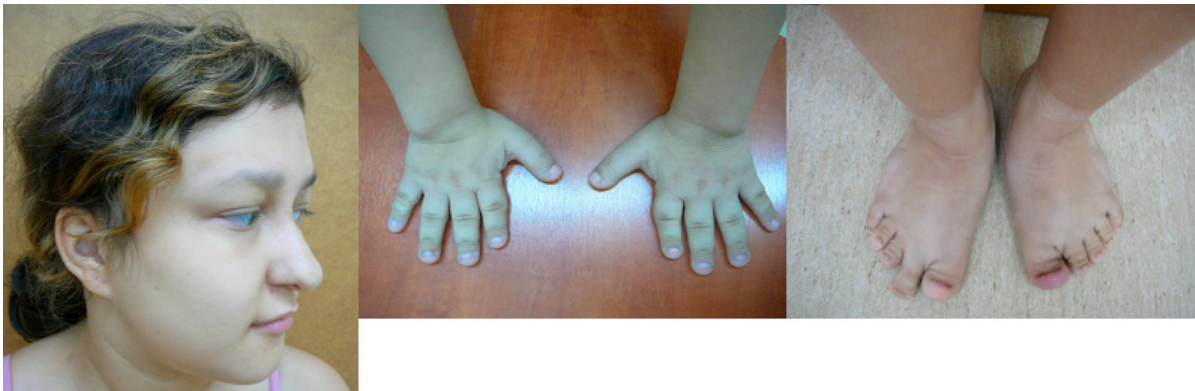
Figure 4. Facial features of patients suspected to have KBG syndrome without ANKRD11 mutations: Patient 24 ‐ a,b— Weiss ‐ Kruszka syndrome; Patient 25 ‐ a,b—Keipert syndrome; and Patient 26 ‐ a,b—Pierpont syndrome. In all patients, note the elongated palpebral fissures and short nose, which were the bases of KBG syndrome suspicion, apart from other clin ‐ ical signs.